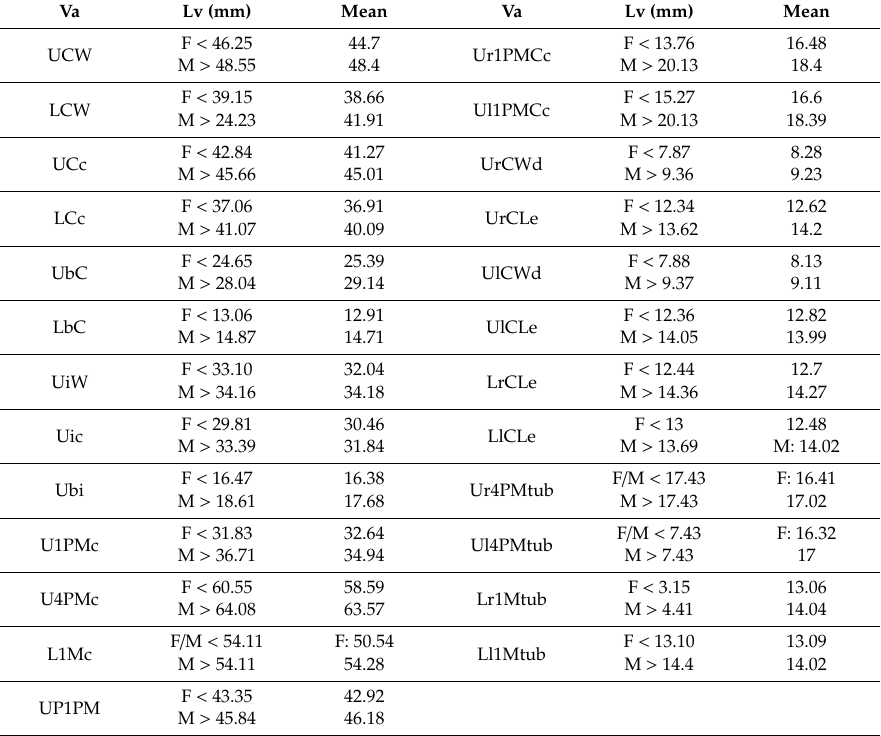
Figure 6. Intervals of the dental measurements considering sex as a source of variation. The minimum, maximum, mean, and quartiles values for each variable according to sex. The black points are the outlier values. ( A ) Measurements taken between right and left canine and between right and left incisors on maxillary and mandibular bones; ( B ) Measurements taken between right and left premolars and between molars; ( C ) Measurements taken on canines, ( D ). Measurements taken on premolars and molars teeth. Table 2. Absolute limits of the variables for the wolf sex di ff erentiation (95% confidence), considering 26 female and 19 male skulls. Va: variable; Lv: Limit value for the sex di ff erentiation; F: females; M: males; mm: millimetres; F / M: sex di ff erentiation was not